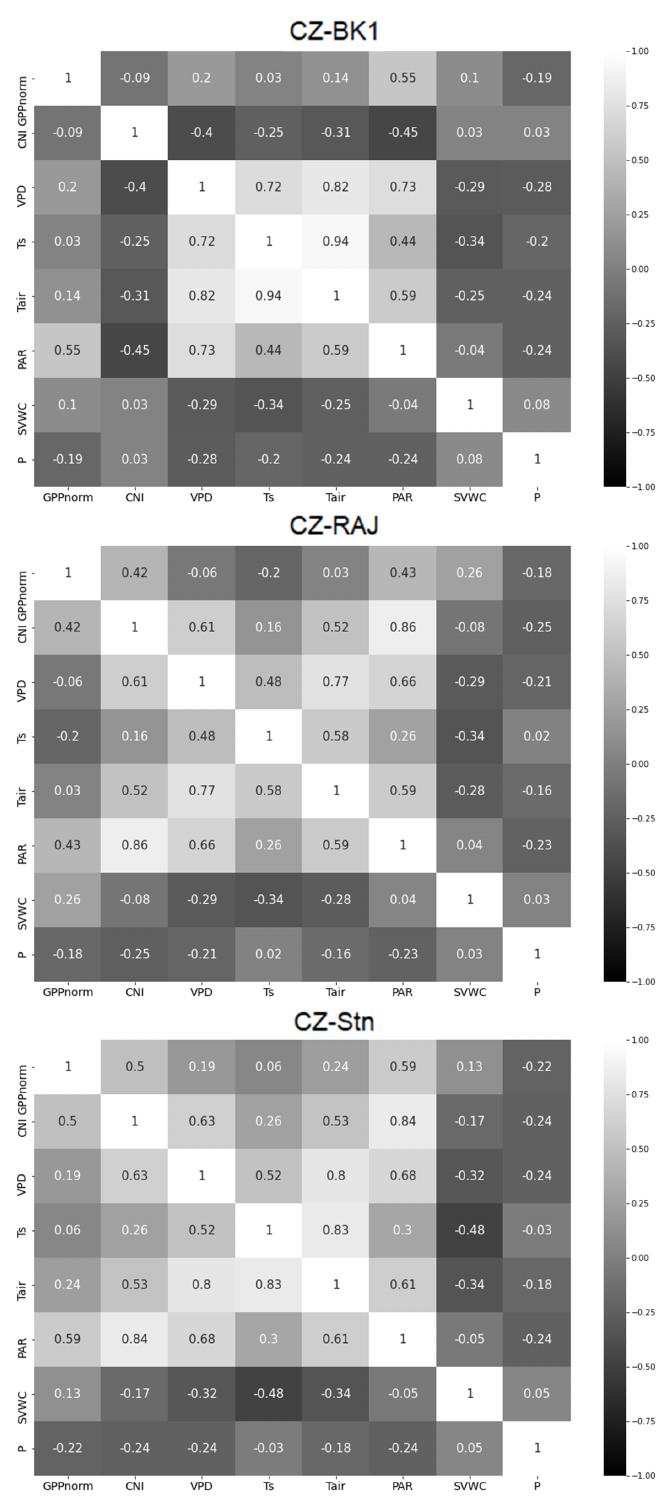
Figure A2. Pearson correlation coefficient matrix showing correlation coefficient between the envi- ronmental variables and the normalized gross primary productivity (GPP norm ) across the wet spruce forest in Bílý K˘rí˘z (CZ-BK1), the dry spruce forest in Rájec (CZ-RAJ) and the beech forest in Štítná (CZ-Stn) sites for May–September of 2012–2016 (shown in the upper panel). CNI: clearness index; PAR: photosynthetic available radiation; T air : air temperature; T s : soil temperature; AWR1: available water resource; VPD: vapour pressure deficit; P: